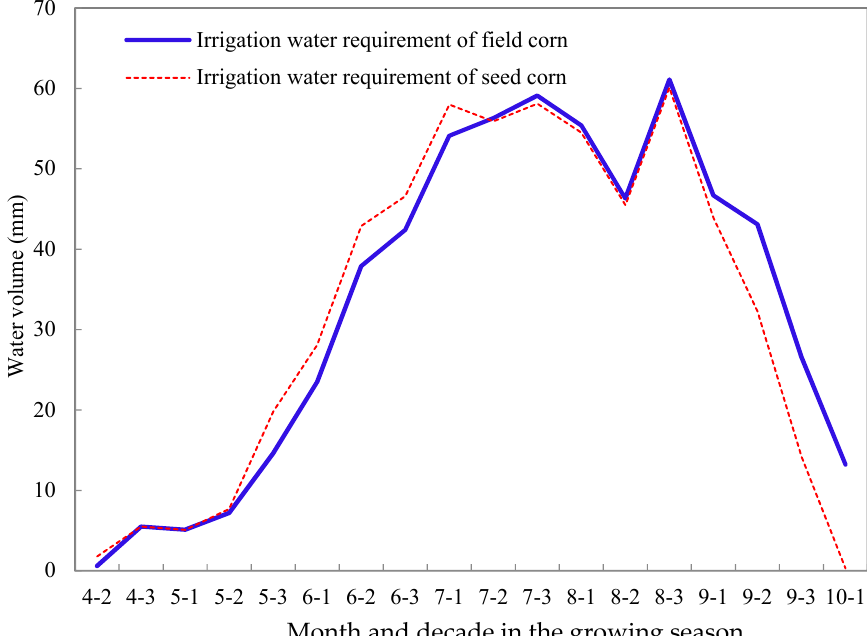
Figure 3. Decadal evapotranspiration of seed corn and field corn. Note: In the horizontal axis, figures before and after the hyphen represent month and decade, respectively. For instance, 5-1, 5-2, and 5-3 represent early May, mid-May, and late May.